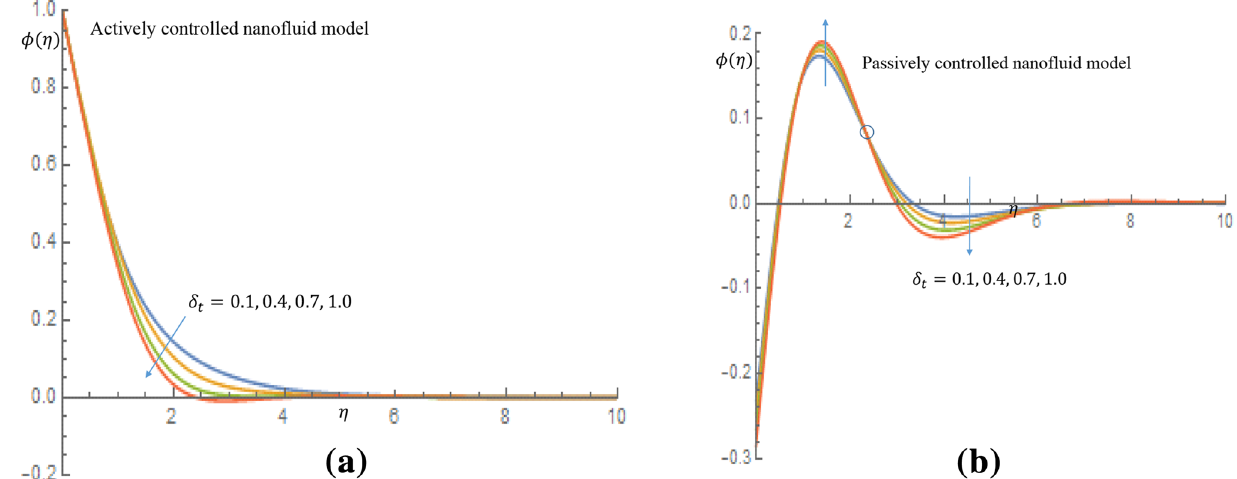
Figure 9. ( a ) Effect of δ t on nanoparticles concentration profile when K 1 = K 2 = 0 . ( b ) Effect of δ t on nanoparticles concentration profile when K 1 = K 2 = 0 .